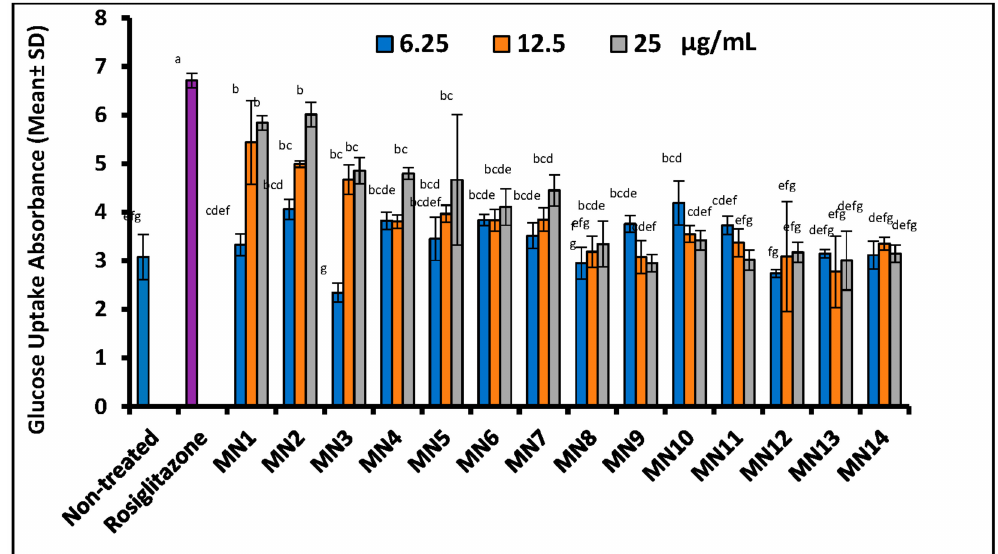
Figure 8. The effect of flavonoids on glucose uptake measurement of adipocyte cells. Small letters represent Tukey’s test. Mean ± S.D., n = 3, means values that do not share a letter are significantly different ( p <